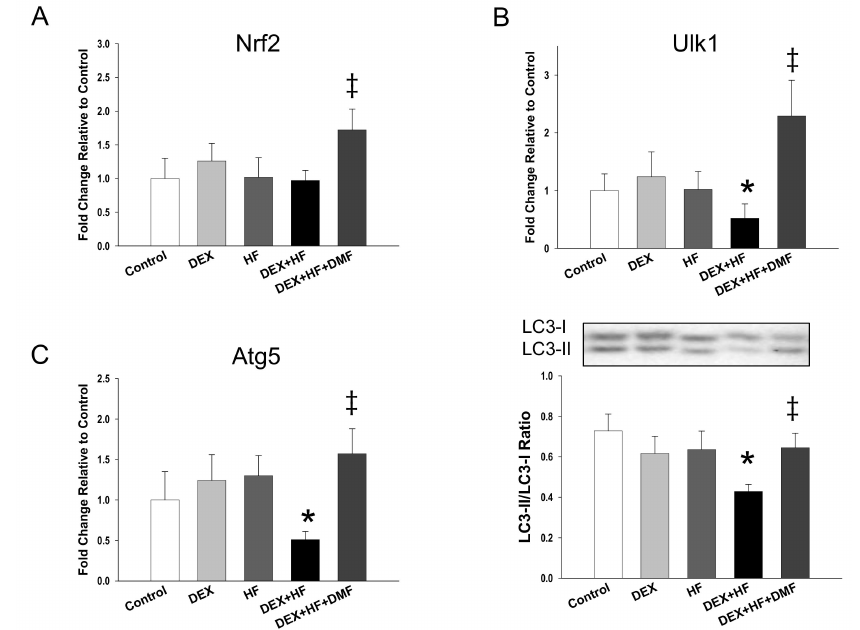
Figure 5. E ff ects of prenatal dexamethasone (DEX), postnatal high-fat diet (HF), and dimethyl fumarate (DMF) on mRNA expression of ( A ) Nrf2 , ( B ) Ulk1 , and ( C ) Atg5 , and ( D ) protein levels of LC3-II (14 kDa) / LC3-I (16 kDa) ra tio in male o ff spring kidneys at 16 weeks of age. * p < 0.05 vs. control; ‡ p < 0.05 DEX + HF. n = 8 /